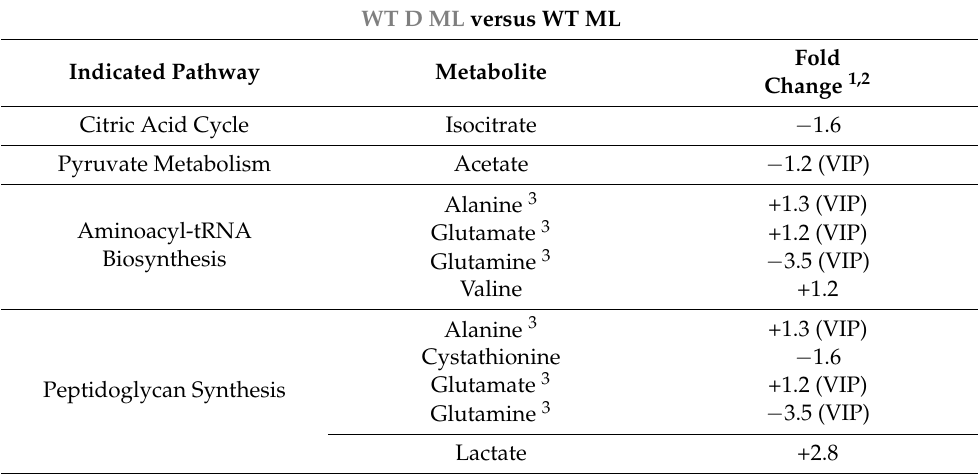
Table 6. Fold change of statistically significant metabolites in their corresponding metabolic pathways for the mid log phase of DABCOMD challenged wild type versus unchallenged wild